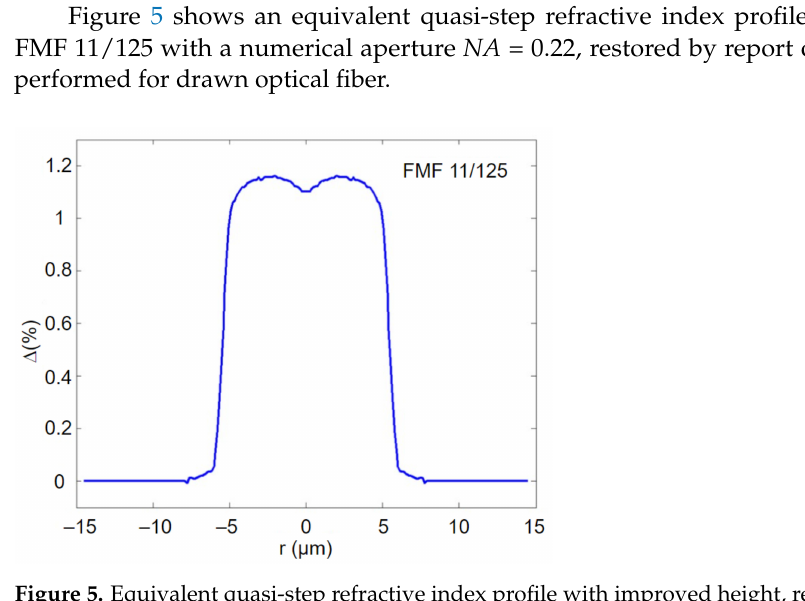
Figure 5. Equivalent quasi-step refractive index profile with improved height, restored by measure- ment report data.